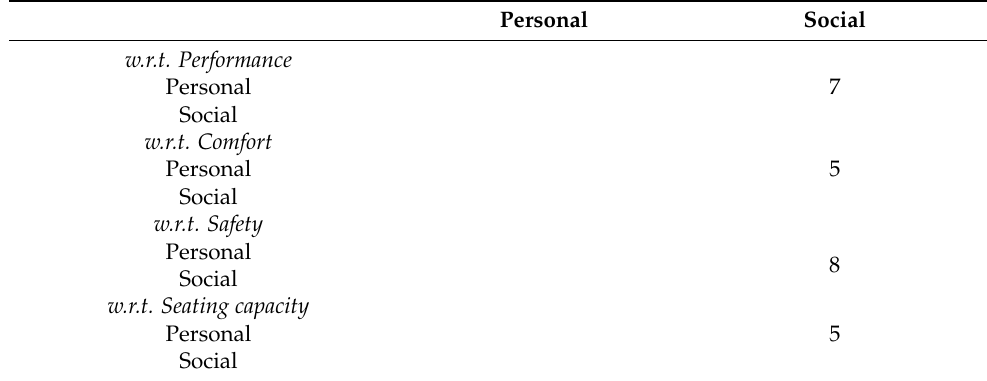
Table 4. Pairwise comparison matrix of PERSONAL AND SOCIAL with respect to the sub-criteria of FUNCTIONALITY.